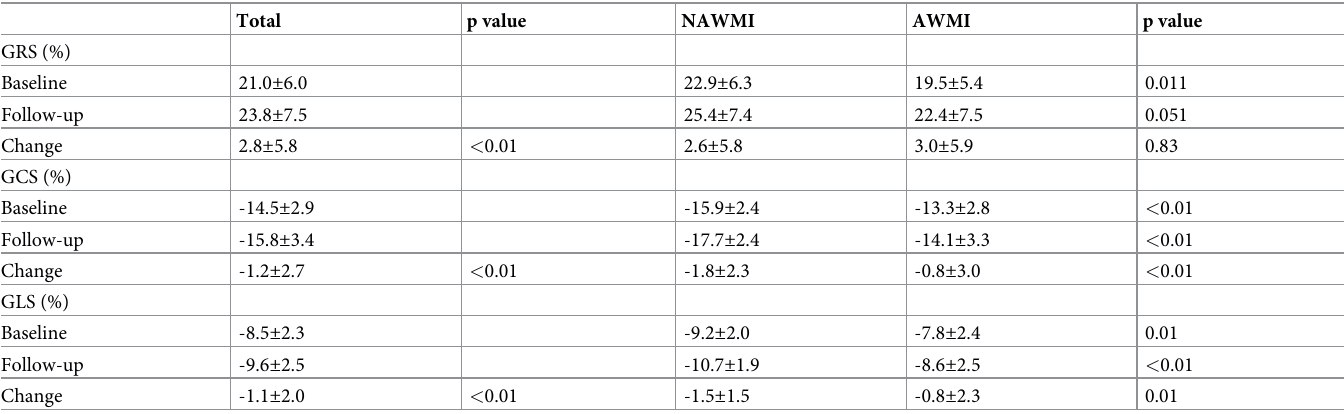
Table 2. Recovery of global strain in AWMI versus NAWAMI groups.